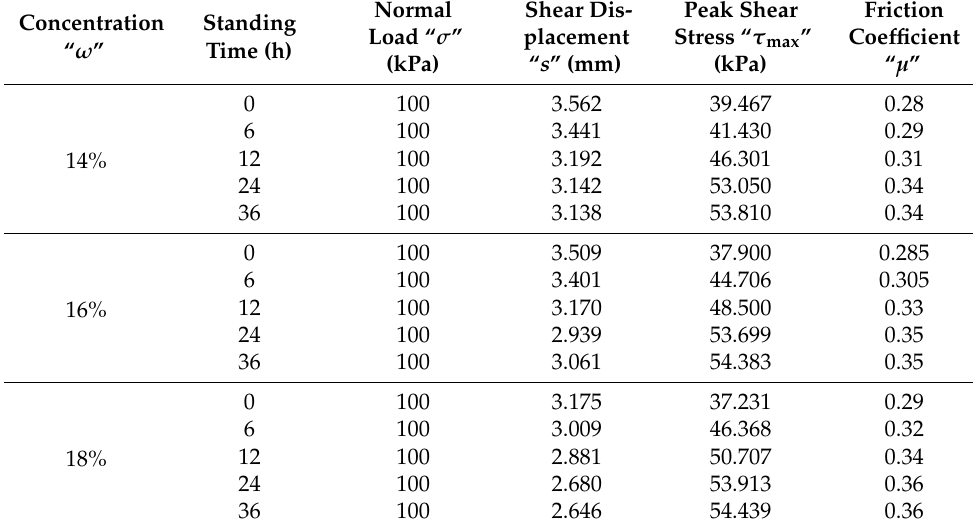
Table 3. Friction test data of the pipe–soil interface at different standing times.